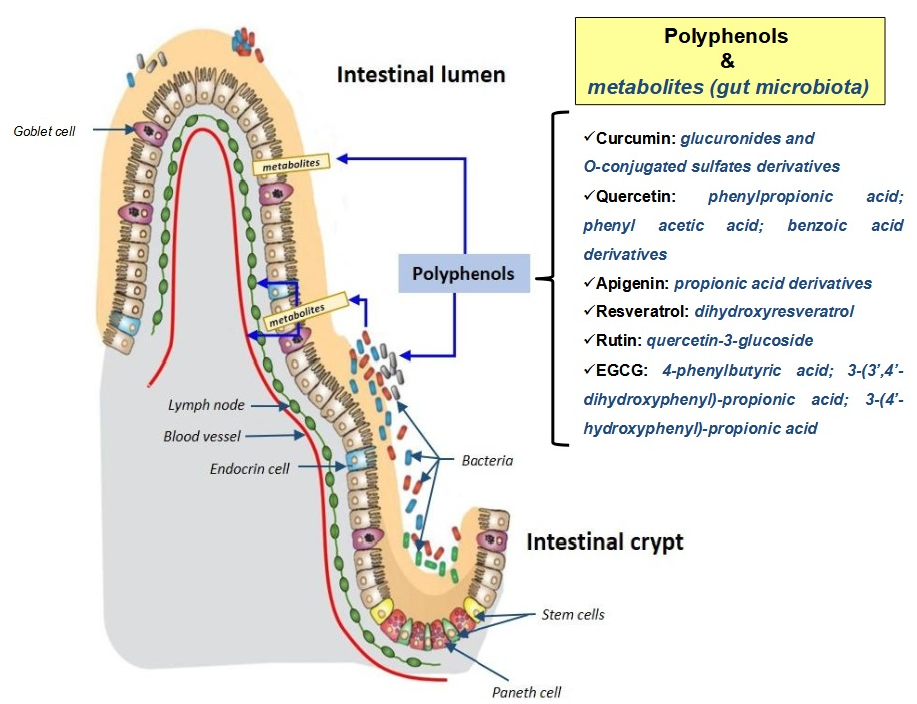
Figure 4. Contribution of the gut microbiota to polyphenol metabolism. The metabolites of polyphenols (curcumin, quercetin, apigenin, resveratrol, rutin and EGCG) produced by the gut microbiota are written in blue.